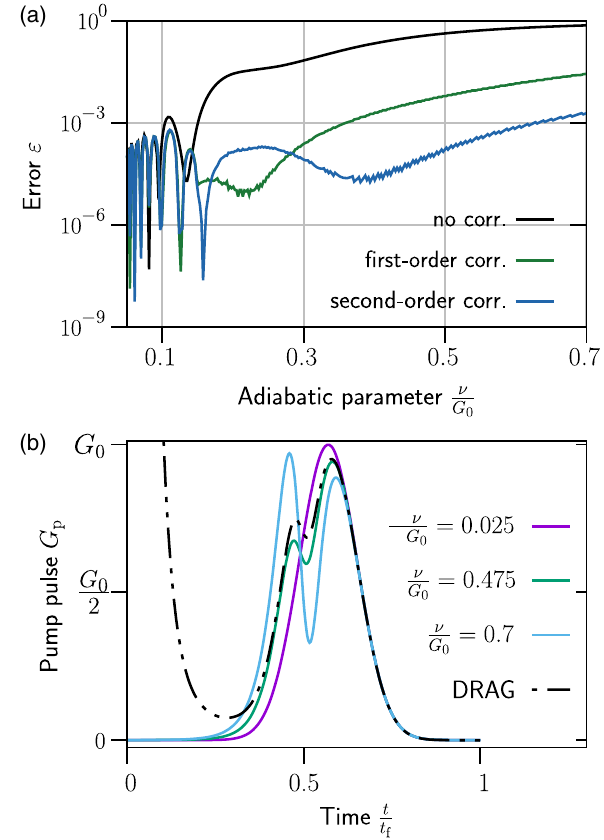
FIG. 4. (a) Fidelity error for STIRAP-style state transfer, as a function of adiabatic parameter ν =G 0 , for uncorrected pulses having a simple Gaussian form. Curves correspond to different choices of correction: “ Uncorrected ” control sequence defined in Eq. (44) (black), first-order Magnus-corrected controls (green), and second-order Magnus-corrected controls (blue). (b) Modified t Þ predicted by the second-order Magnus pump pulse G p ð algorithm as a function of t=t for different values of ν =G 0 . f As ν =G 0 → 0 , the modified sequence converges to the original one. The Stokes pulse is the time reverse of the pump pulse. The black dashed line is the control predicted by DRAG for ν =G 0 . 475 . As one can observe, this control diverges when 0 ¼ t → 0